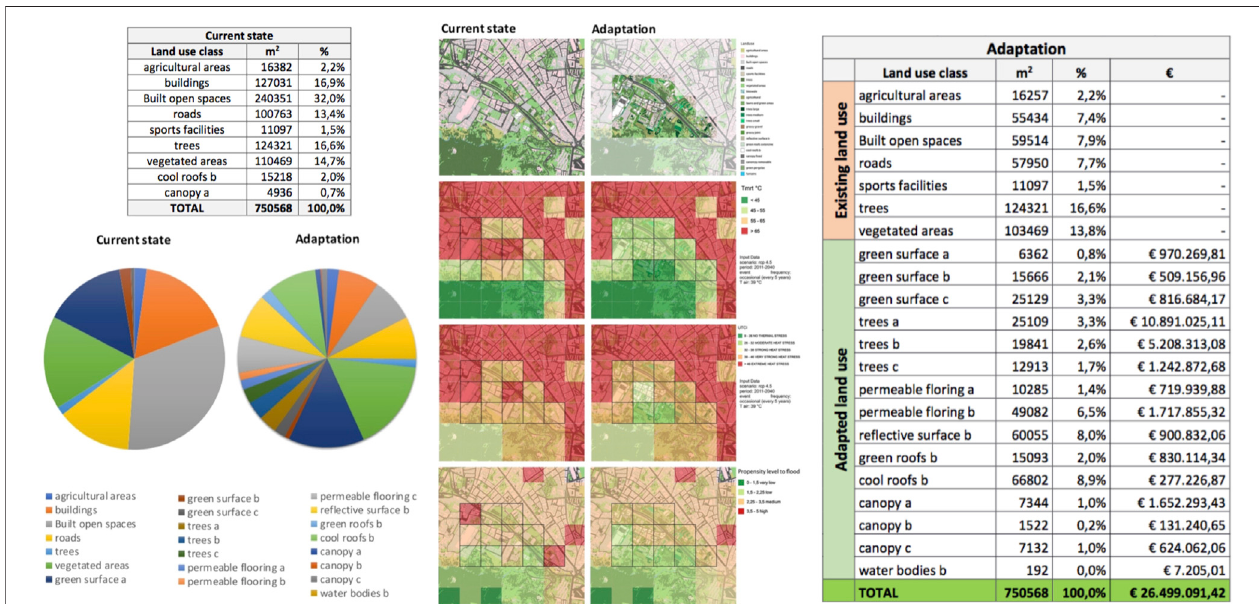
FIGURE 11 | Cost of climate adaptation at the city level, considering an “ ideal ” strategy towards 2030 and 2050.